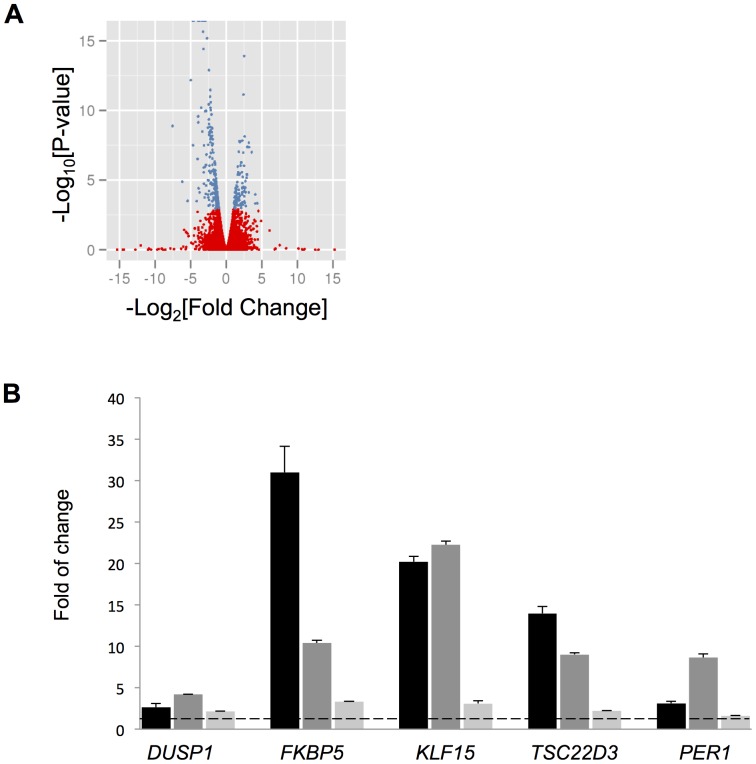
RNA-Seq profiling of DEX-treated ASM cells.
A) Volcano plot of overall gene-based differential expression results for four cell lines treated with DEX vs. left untreated (each dot corresponds to a gene). The y-axis corresponds to the negative log (base 10) of P-values while the x-axis corresponds to the negative log (base 2) of the fold change for difference in expression when cells were stimulated with DEX. There were 316 differentially expressed genes according to an adjusted p-value <0.05 (blue dots). B) Validation of known GC-responsive genes through qRT-PCR. After ASM cells were treated with 1 µM DEX for 18 h, the mRNA levels of indicated genes were measured by qRT-PCR and the folds of change in mRNA induced by DEX were calculated. Each column bar represents an individual cell line. Experiments for each cell line were performed in triplicate, and the error bars are SE values corresponding to a cell line's replicates. The dotted line indicates a fold change of 1. ** P<0.005, * P<0.05 (t test).